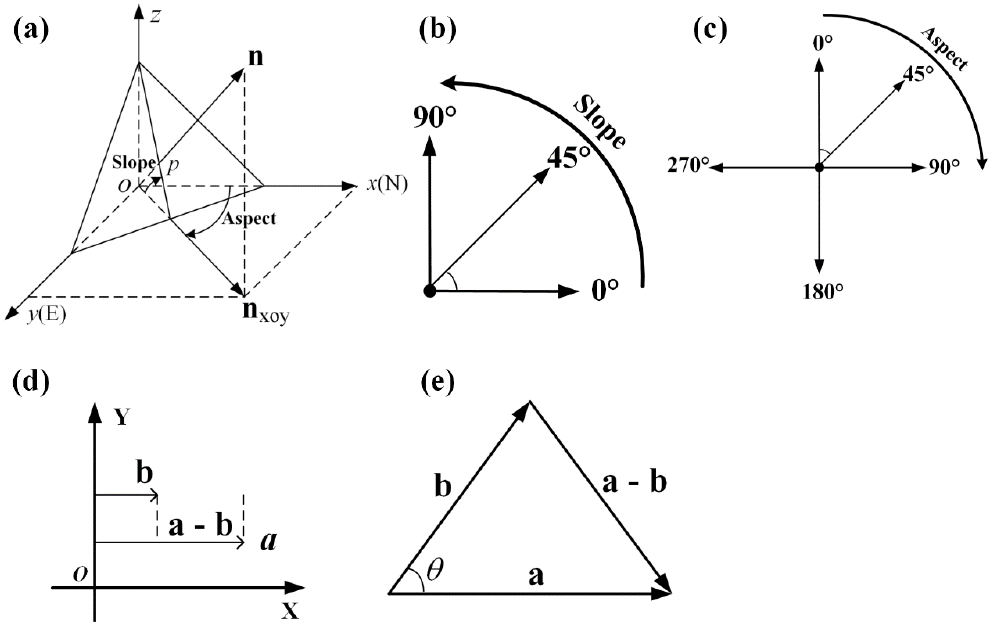
Figure 1. Directional properties of several basic terrain derivatives and scalar and vector operations. ( a ) is the calculation principle of slope and aspect on surface point p; ( b ) represents the directional property of slope from the horizontal direction to the zenith direction (counterclockwise); ( c ) denotes the directional property of aspect from the north, to the east, south, west, and back to the north (clockwise); ( d ) is a scalar operation; and ( e ) is a vector operation.